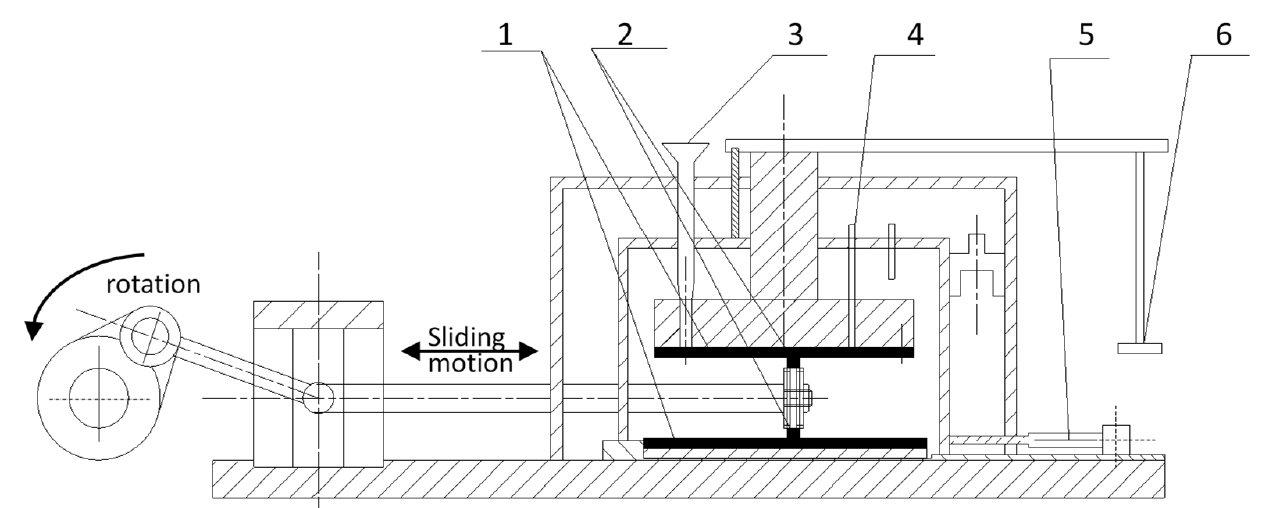
Figure 1. Schematic diagram of the tribometer simulating the friction pair of cylinder liner–piston ring. 1—cylinder liner, 2—piston ring, 3—fuel tank, 4—temperature sensor, 5—pressure sensor, 6—load.